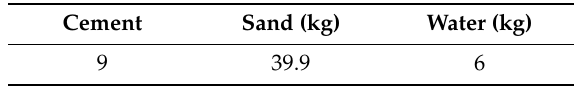
Table 4. Composition of the ordinary Portland cement (OPC)